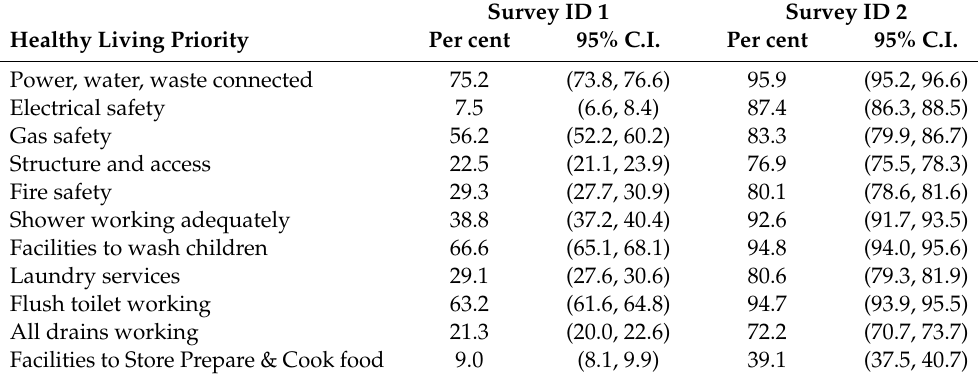
Table A5. Percentage of houses with Critical Healthy Living Priorities fully met at Survey-Fix1 and Survey–Fix 2 for all NSW projects ( n = 112) from 1998–2017.